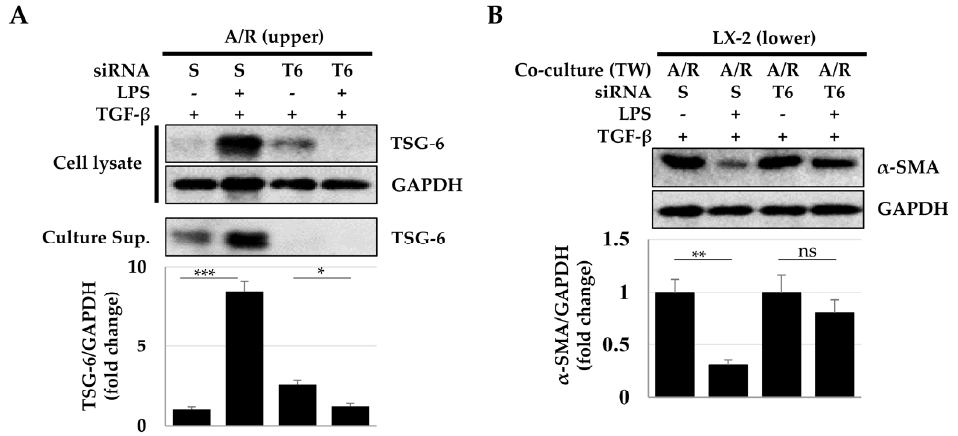
Figure 7. Effects of TSG-6 siRNA treatment in ASCs and macrophages. To inhibit TSG-6 expression in ASCs and macrophages, ASCs/macrophages or LX-2 cells were seeded in the upper or lower chamber of Transwell wells, respectively. ( A ) TSG-6 expression in ASCs and macrophages 48 h after transfection of TSG-6 siRNA. ( B ) α -SMA expression in TGF- β -treated LX-2 cells 48 h after transfection of TSG-6 siRNA. Data were obtained from one of three independent experiments. * p ≤ 0.05, ** p ≤ 0.01, and *** p < 0.001. ns, no statistical significance.